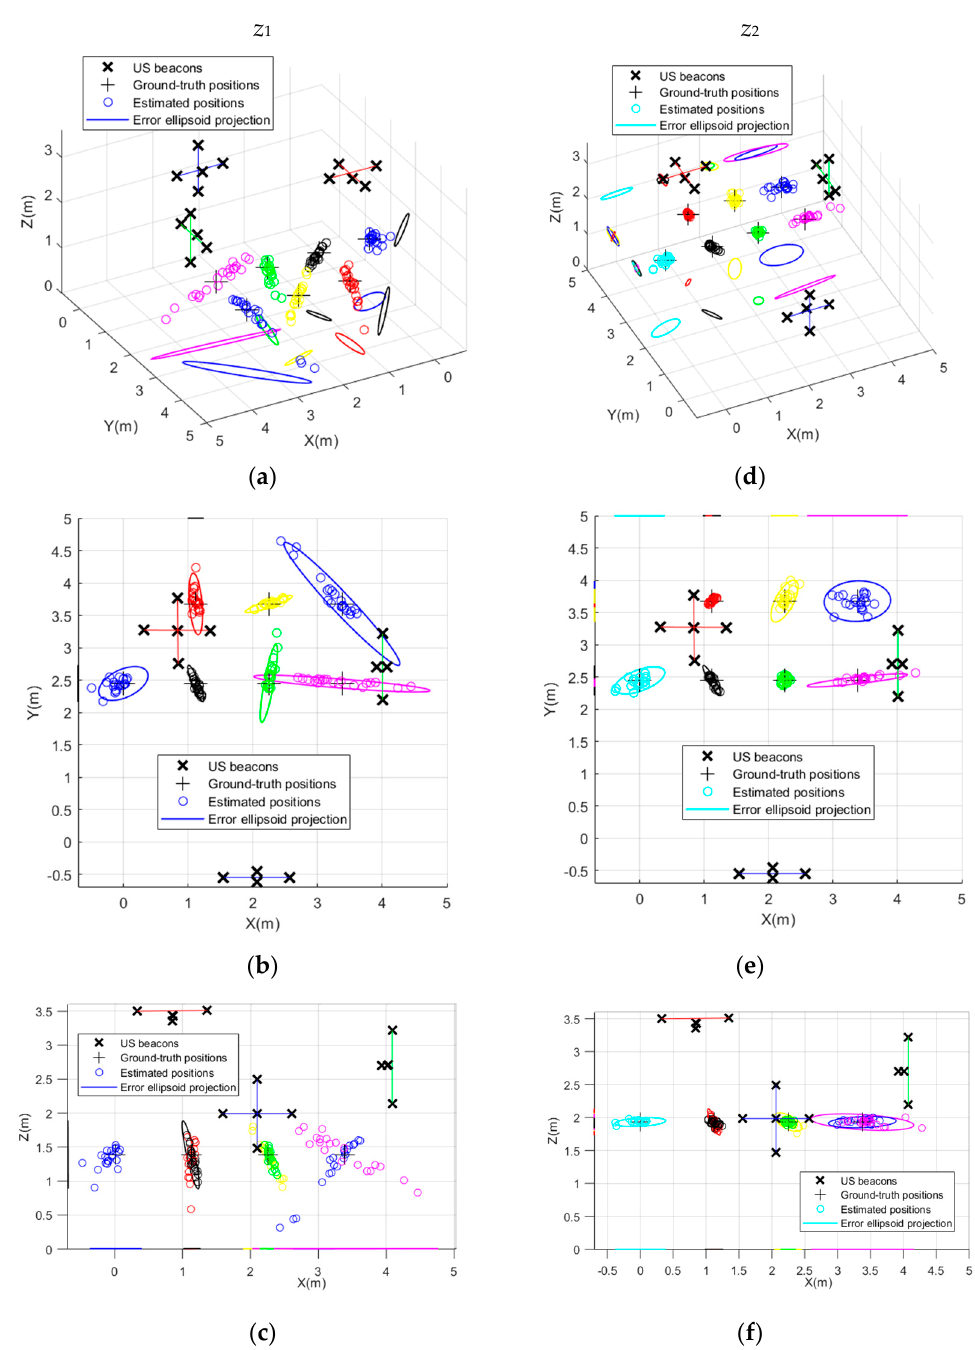
Figure 8. ( a – f ) Estimated positions after the LKF fusion for the points P1–P7, including the projections of their corresponding error ellipsoids with a certainty of 95% in the XY and XZ planes, at z 1 = 1.35 m ( left ) and z 2 = 1.93 m ( right ): successively, 3D representation of clouds of points; Y–X projections; and Z–X projections.